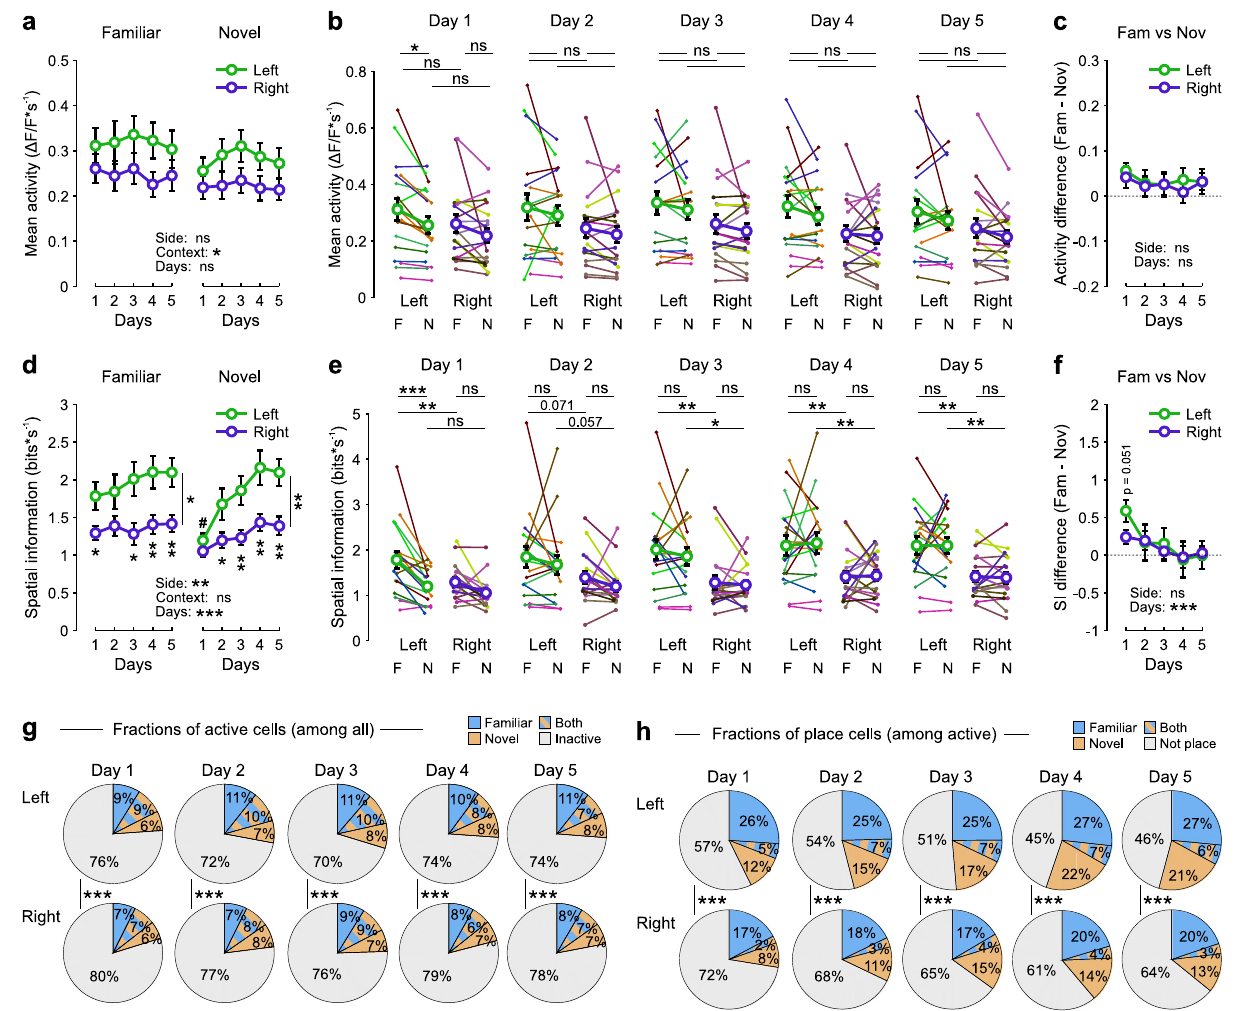
h Fractionof place cellsamong the active cellsdepending on theenvironment. a – f n l eft = 18 datasets, n right = 18 datasets. a , d Three-way repeated measures ANOVAs, Tukey ’ s post hoc test. Side, Context, and Days refer to the three main effects. b , c , e , f Two-way repeated measures ANOVAs (per day for b and e ), Tukey ’ s posthoc test. Side and Days refer to the two main effects. g n left =4224 cells, n right = 4224 cells; h n left =1009 – 1255 cells, n right = 904 – 1096 cells. g , h Testforpopulationoverlap( χ 2 test).ns,notsigni fi cant;* P < 0.05;** P < 0.01; *** P < 0.001. In d , * P < 0.05 or ** P <0.01, different from the other group (left vs right) for each individual day; # P < 0.05, different from the same group in the other environment on day 1 (familiar vs novel); P value combined with a bar shows comparisons between left and right for all days in the familiar and the novel track. Circles with lines indicate mean± SEM. For exact P values, see Supplementary Table 1. Source data are provided as a Source Data fi